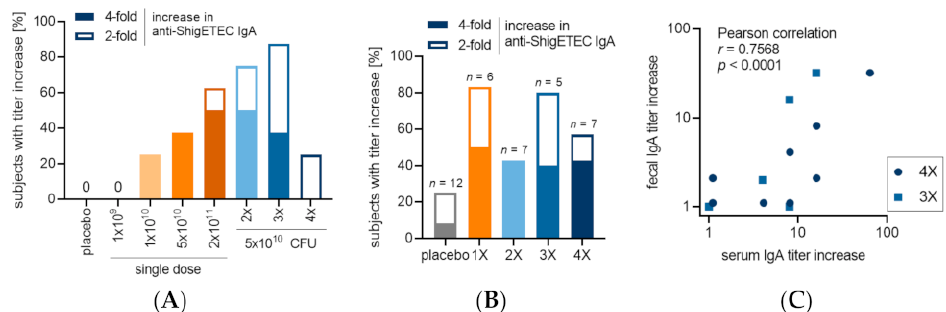
Figure 5. Anti-ShigETEC IgA responses in ALS and stool extracts. ( A ) anti-ShigETEC IgA responders in ALS ( B ) anti-ShigETEC IgA responders in stool extracts from available samples with sufficient total IgA content to allow comparison of samples collected at different time points from the same subject ( C ) Pearson correlation between fecal and serum IgA titer increases detected by ELISA using ShigETEC lysate as antigen with samples of individuals in the three-dose (square) and four-dose (circle) groups.